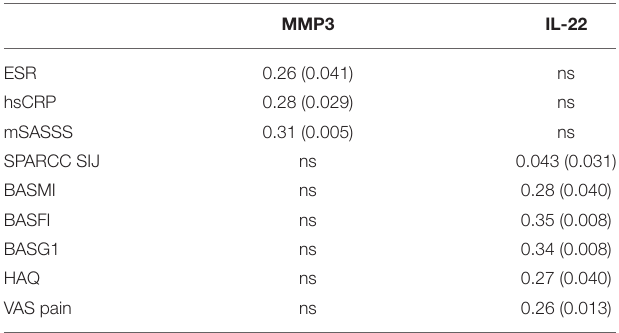
TABLE 2 | Correlations between MMP3, IL-22 and clinical indices and imaging scores.